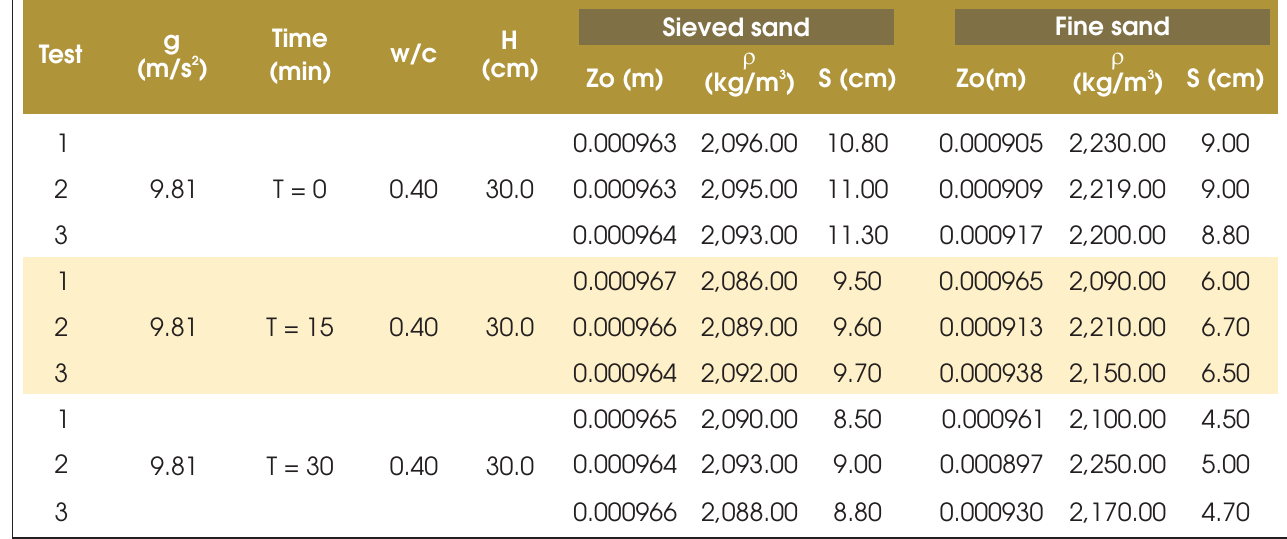
Table 7 – Method of Pashias: parameters needed to calculate the yield stress of the mortars with w/c = 0.40